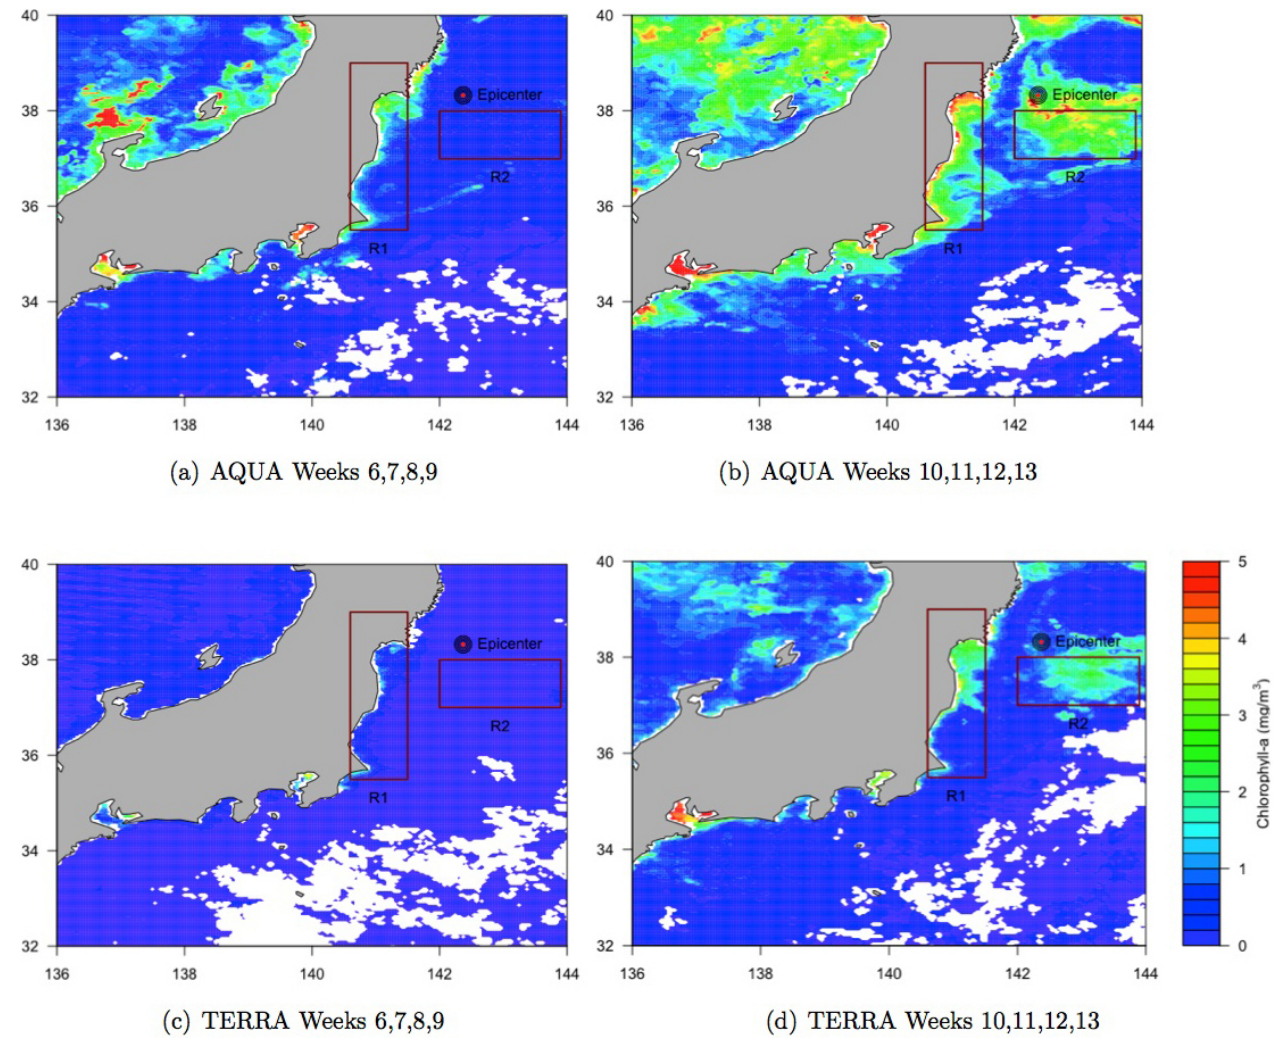
Figure 6. Average chlorophyll concentration for 4 weeks before (left) and after (right) the tsunami for AQUA (top) and TERRA (bottom). The vertical axis indicates latitude degrees north, and the horizontal axis indicates longitude degrees